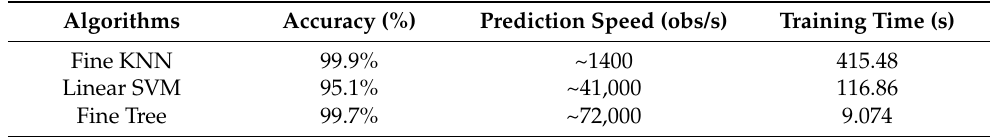
Table 7. Performance analysis of algorithms on physical activities